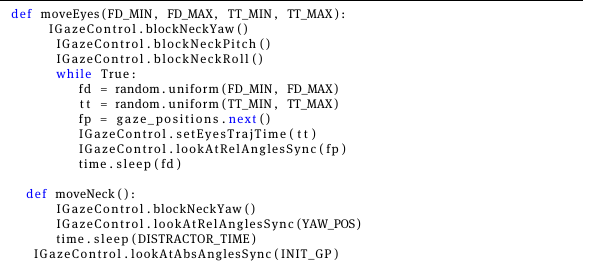
14IGazeControl.blockNeckYaw() 15IGazeControl.lookAtRelAnglesSync(YAW_POS)